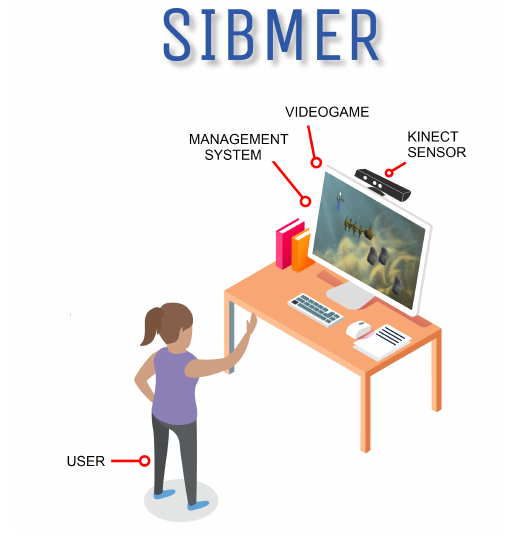
Figure 2. Architecture of